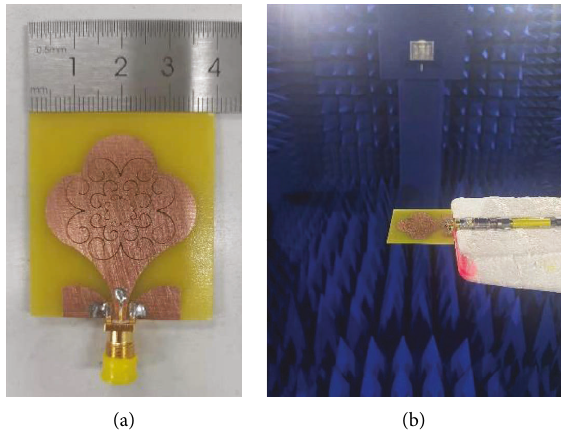
Figure 11: (a) The antenna prototype. (b) The antenna is tested in an electromagnetically shielded darkroom.